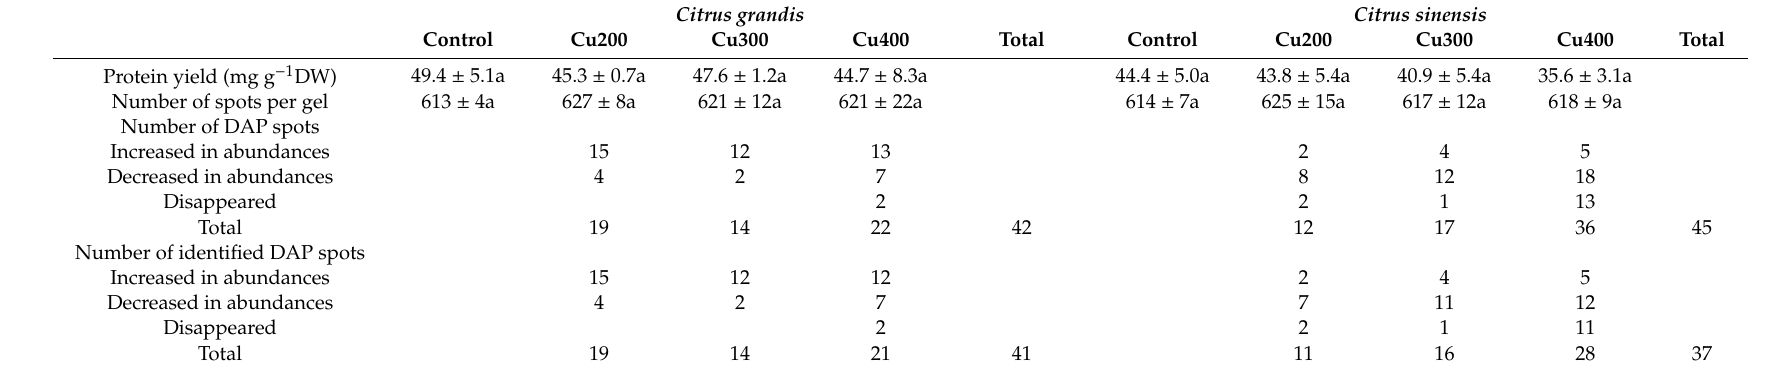
Table 1. Protein yield, number of di ff erentially abundant protein (DAP) spots and number of identified DAP spots in 0.5 (control), 200 (Cu200), 300 (Cu300) or 400 (Cu400) Cu-treated Citrus grandis and C. sinensis